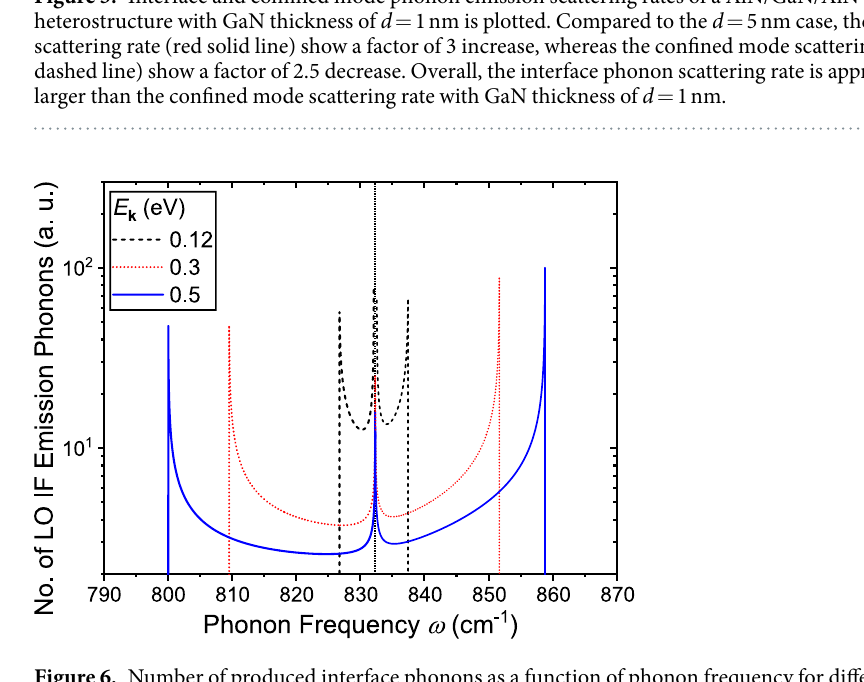
Figure 6. Number of produced interface phonons as a function of phonon frequency for different electron energies E k = 0.12 (black dashed line), 0.3 (red dotted line), and 0.5 eV (blue solid line) are shown. Only the interface phonons involved in the LO emission phonon process are plotted. The LO phonon resonant frequency is indicated as the vertical dotted line. The y -axis represents the integrand of Eq. (9) or equivalently the number of phonons emitted with each phonon